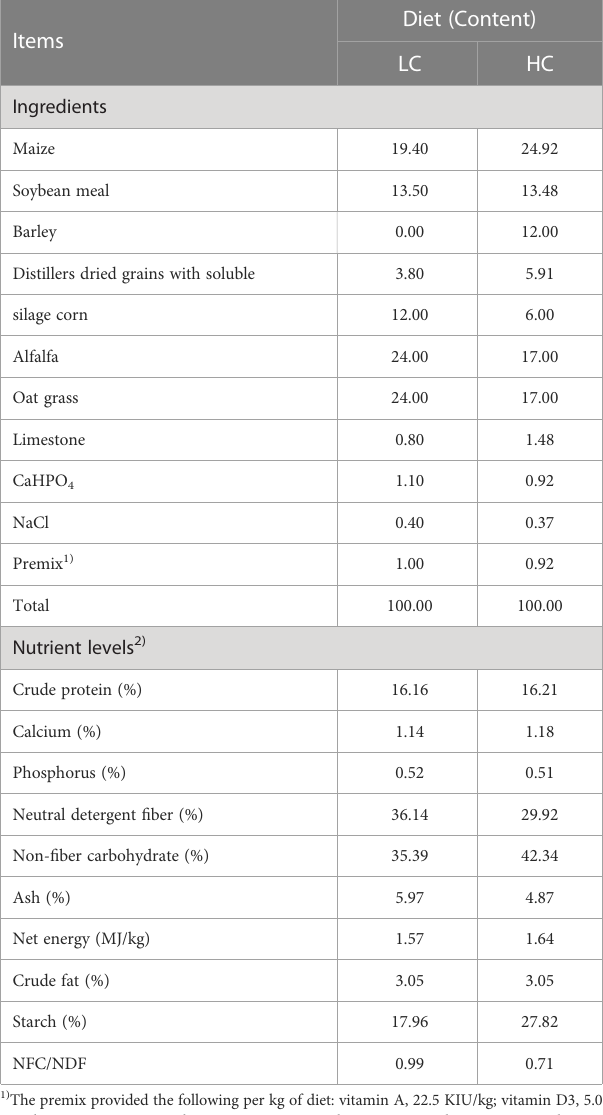
TABLE 1 Ingredients and nutrient contents of the low-concentrate diet and high-concentrate diet (DM basis,